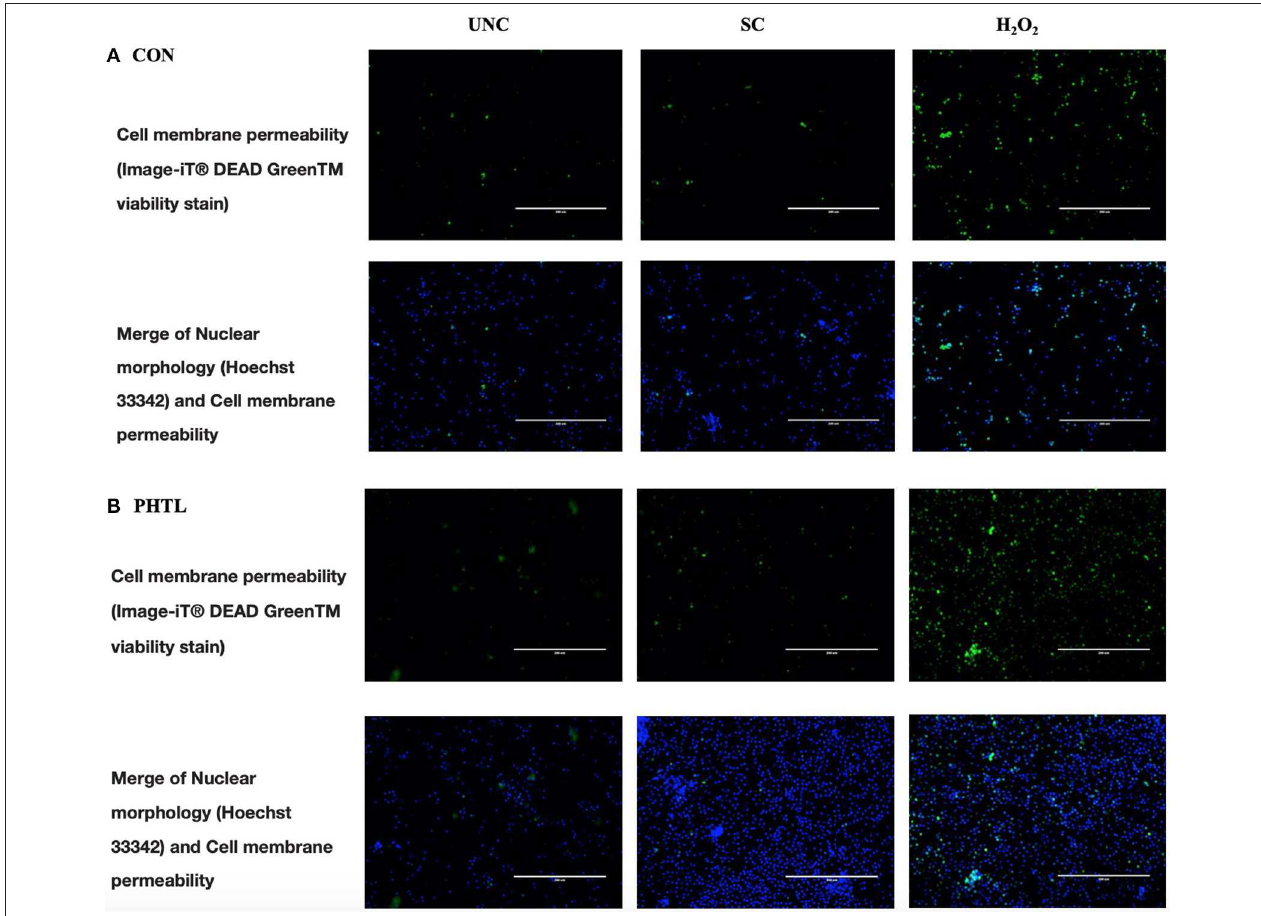
FIGURE 2 | Imaging of PBMCs from the CON group (A) and from the PTHL group (B) , and viability was obtained using the Image-iT ® DEAD GreenTM Viability Stain. PBMCs were untreated (UNC), treated with LPS and ConA (SC, 1 and 5 µ g/ml, respectively) and with 4mM of H 2 O 2 , and incubated for 24h at 37 ◦ C/5% CO 2 . Then, PBMCs were stained with Image-iT ® DEAD GreenTM viability stain for 30min, fixed, permeabilized according to the manufacturer’s instruction, and imaged on Life Technologies EVOS TM XL Imaging System (Milan, Italy). The nucleus was detected with Hoechst 33342 (blue) in the DAPI/Hoechst channel, and the cell membrane permeability was detected in the FITC/GFP channel